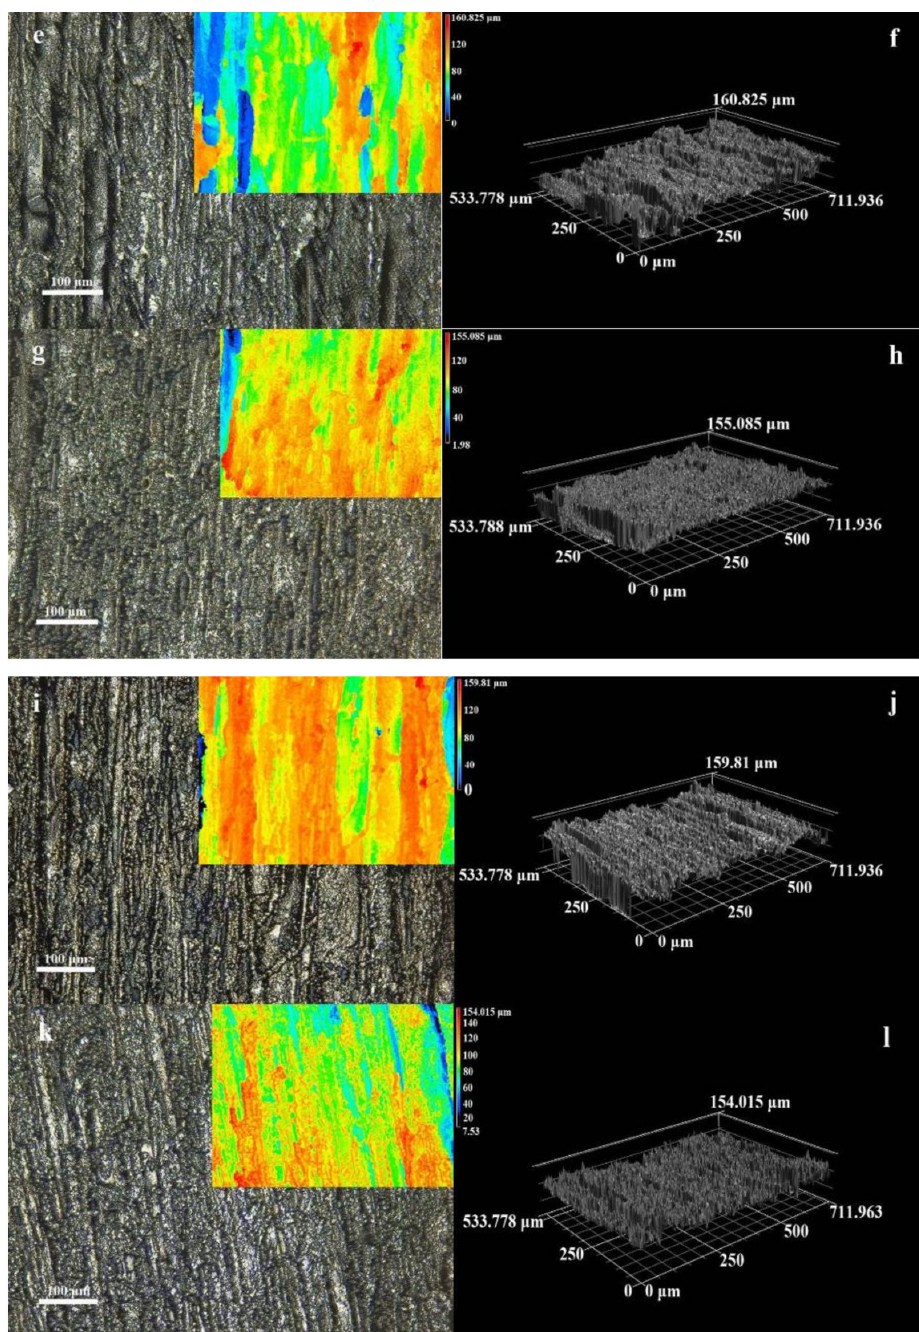
Figure 7. The morphology of the third electroless Ni wood surface by laser copolymerization microscope was 200 × (( a , c , e , g , i , k ) followed by the morphology of the wood surface after electroless Ni for 1, 5, 10, 15, 20, 25 min. The embedded figure is the well depth figure; ( b , d , f , h , j , l ) is 3D figure of electroless time 1, 5, 10, 15, 20, 25 min,